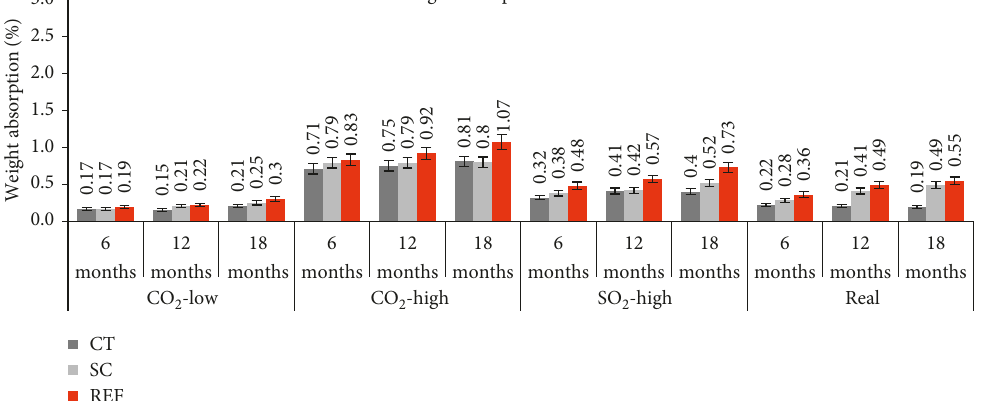
Figure 7: Comparison of the absorption of concrete exposed to gaseous aggressive environments and the real environment. The error bars represent the range of measurements for 3 samples.